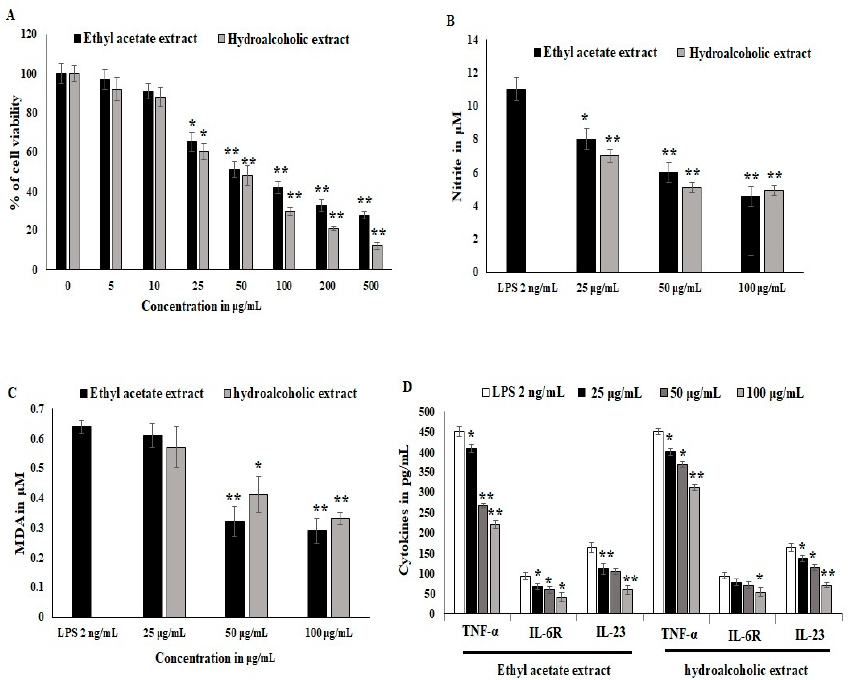
Figure 1. Effects of Optunia littoralis (OL) EAE and HAE extracts on cell viability of murine macrophagic cell line RAW 264.7 and mouse synovial-like fibroblastic cells. ( A ) Confluency cell lines were trypsinized and seeded with 10 4 cells per well in a 96-well plate and set to adhere for 12 h. After adherence, OL- EAE and OL- HAE extracts were treated at 500, 200, 100, 50, 25, 10, and 5 µ g/mL concentrations for 24 h, and the SRB assay was used to determine cell viability after treatment. ( B , C ) NO and MDA levels of IL-6-induced RAW264.7 cells were determined by using the Griess reagent method and Malondialdehyde kit (Biovision, Abcam, Boston, MA, USA). Human macrophage RAW264.7 cells were divided into a control group (no LPS was added), LPS group (treated with 2 µ g/mL LPS for 24 h), and nontoxic treatment group administered at 10 to 50 µ g/mL. NO content in cell supernatant was determined as described in Materials and Methods. MDA values was expressed as µ M. ( D ) Inflammatory cytokines TNF α , IL6R and IL23 were quantified using ELISA kit. All